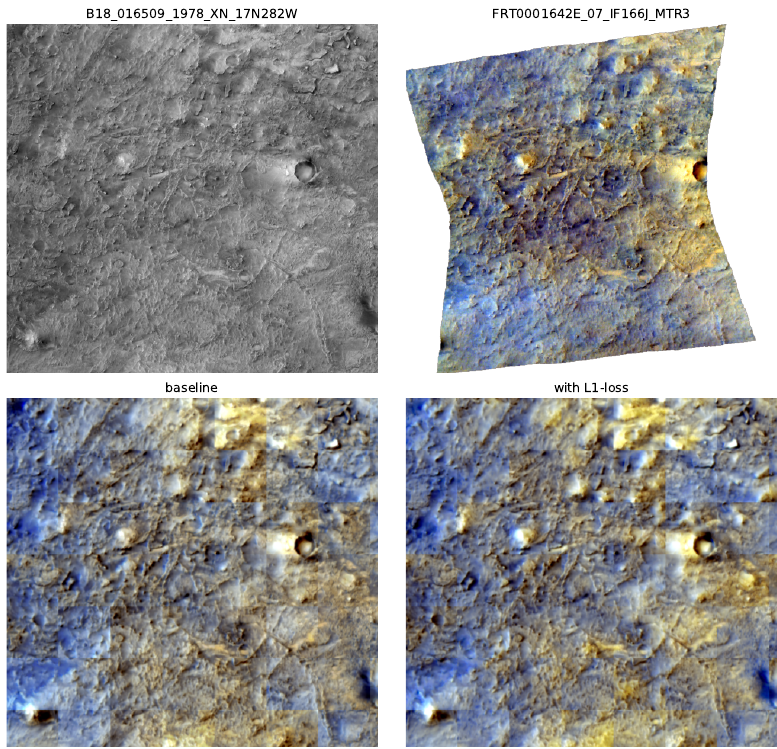
Figure 18. Full Jezero crater validation CTX-CRISM EVC pair ( top row ), with prediction using the baseline classification model ( bottom left ) trained with an L1-loss component ( bottom right